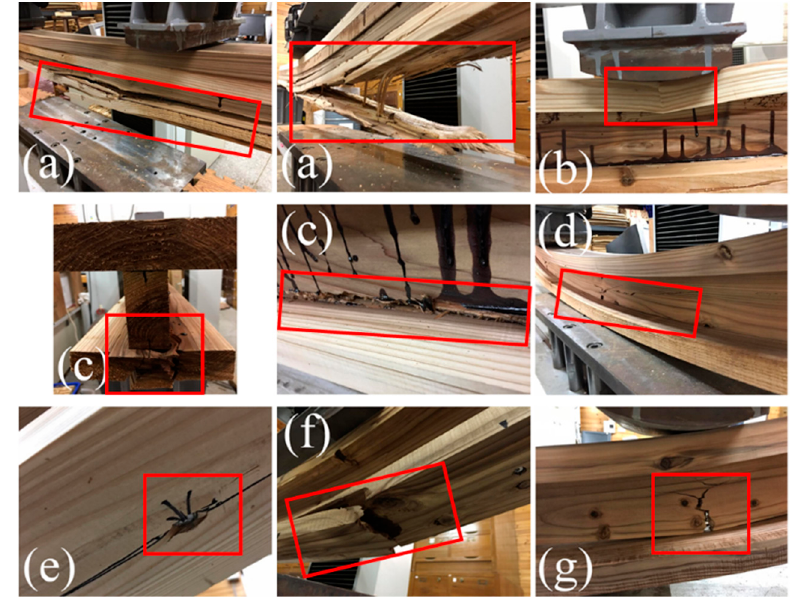
Figure 7. Failure modes of the developed built-up and glulam beams: ( a ) tensile failure at bottom of glulam, ( b ) compression failure at top flange, ( c ) failure at wood on glued surface, ( d ) horizontal shear failure at the web, ( e ) crushing on the surface using self-tapping screws, ( f ) failure at knot, and ( g ) crack at the self-tapping screw joint location.